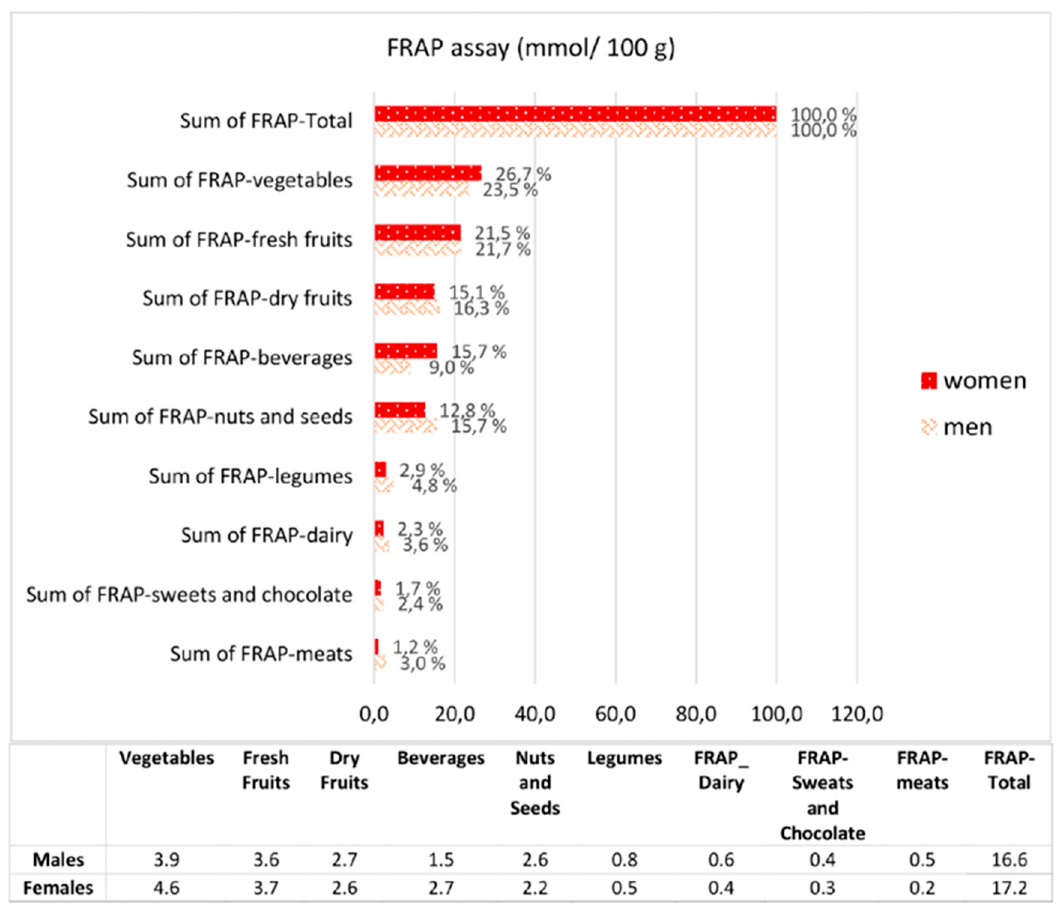
Figure 1. The contribution of foods and beverages to dietary total antioxidant intake according to FRAP assay [27]. Table 2. Plasma oxidative stress parameters before and after the exercise